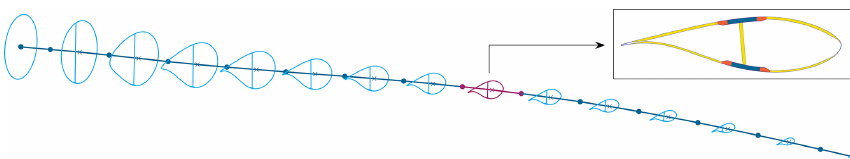
Figure 1. Exemplary finite element beam with reduced number of elements and exemplary cross-sectional illustration. The detail shows a cross-sectional BECAS output (Blasques and Stolpe, 2012) as used in the feasibility study (Noever-Castelos et al., 2021).